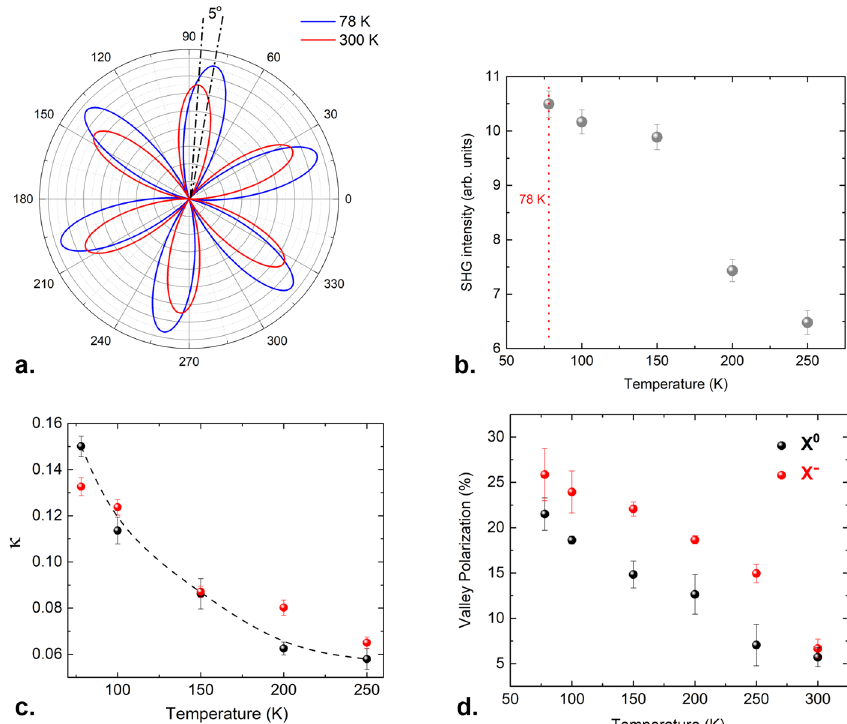
Fig. 4 Temperature dependence of second harmonic generation intensity, valley population imbalance and spin-valley polarization. a Comparison between the SHG polar diagrams fi tted to the experimental data, for the highest (red) and lowest (blue) considered temperatures. With decreasing temperature, the SHG intensity increases due to the valley-induced contribution. A rotation of the polar diagram away from the main crystallographic axis is also reported. b Temperature dependence of the integrated SHG intensity. c Temperature dependence of the calculated parameter κ , for two regions of interest. d PL measurements of temperature-dependent spin-valley polarization for the neutral (black) and charged (red) exciton in the same